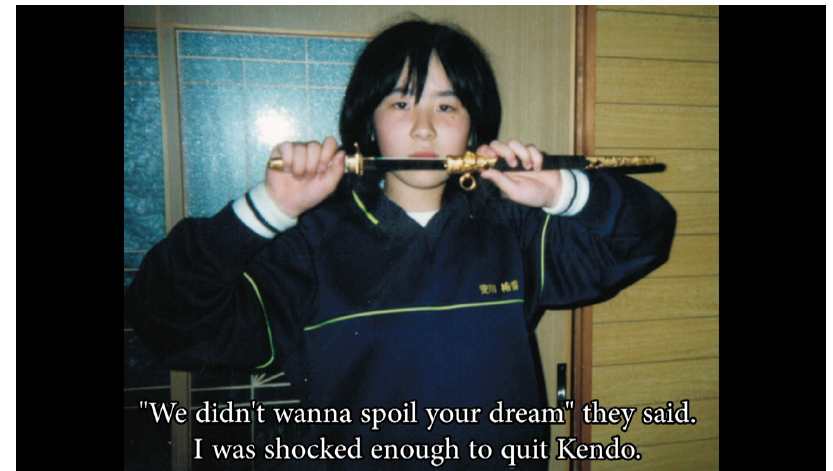
Fig. 1. Yuka with a seppuku knife. Gamushara (Takahara,